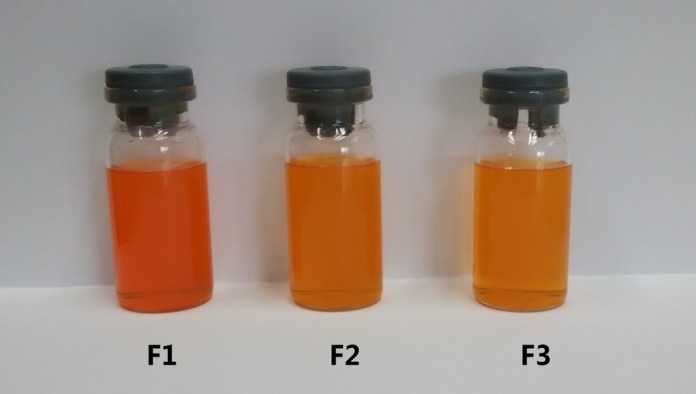
Images of cryptotanshinone loaded ethosomes.